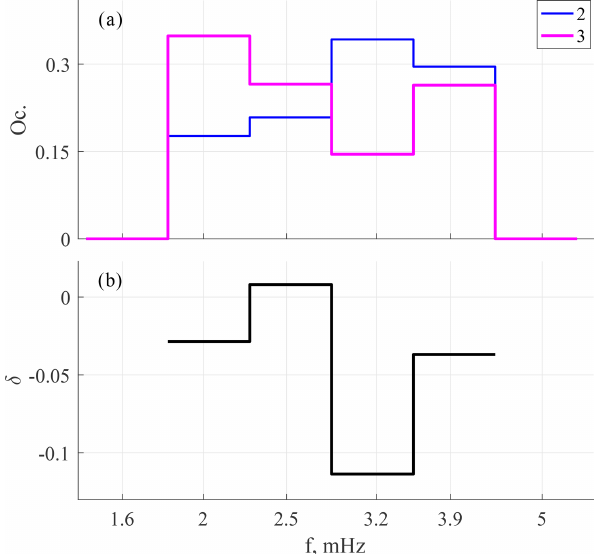
Figure 11. Comparison of Pc5-3/Pi3 parameters for Pc5-3/Pi3 (group 2), (cid:49) fo F2 (group 3), coherent (cid:49) fo F2- b X (group 4) and high-frequency coherent (cid:49) fo F2- b X (group 5) intervals: (a) PSD; (b) R X − Y = PSD X / PSD Y ; (c) meridional PSD ratio PSD SOD / PSD MAS